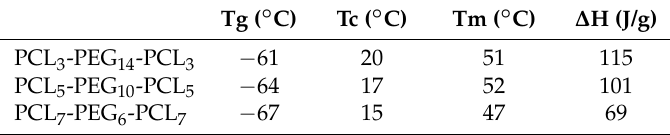
Table 2. Thermal characteristics of PCL- b -PEG- b -PCL triblock copolymers in the dry